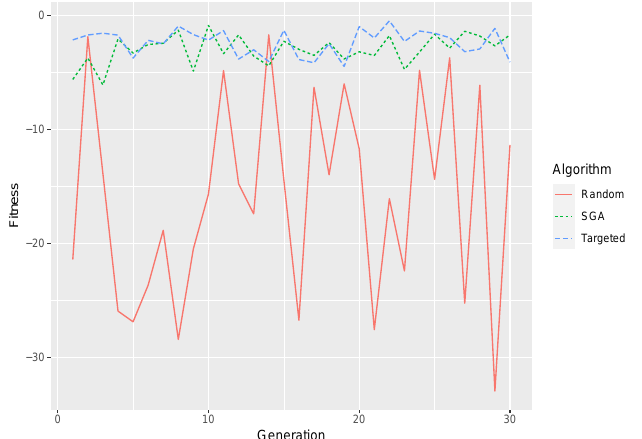
Figure 6. Fitness values over the generations for Rastrigin. Fitness values are inverted for convenience (i.e., higher values are more accurate).